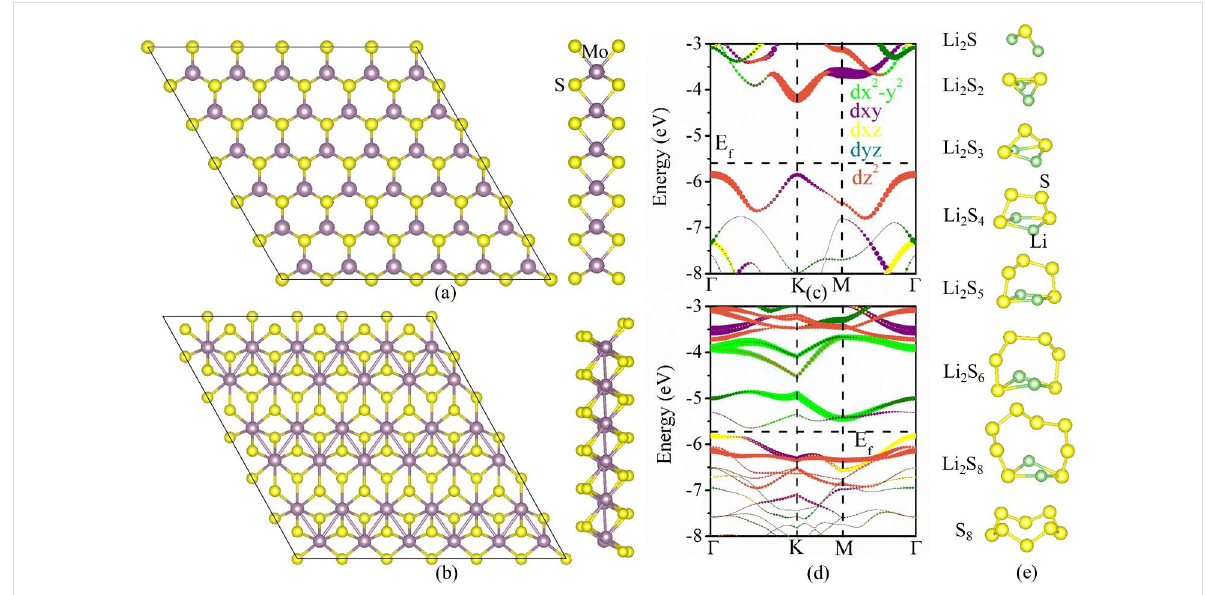
Figure 1: Cross-section and side views of (a) 2H-MoS 2 and (b) 1T'-MoS 2 monolayers. Orbital-decomposed band structures along high-symmetry points of (c) 2H-MoS 2 and (d) 1T'-MoS 2 monolayers. (e) The optimized atomic configurations of Li 2 S x ( x = 1–8) and S 8 in their ground states.